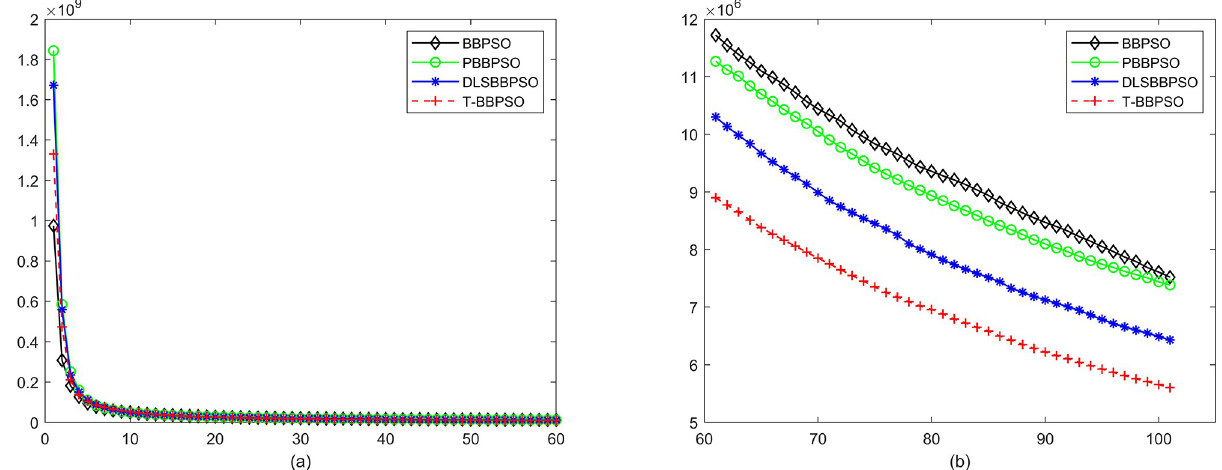
Fig 3. Comparison of convergence speed between BBPSO, PBBPSO, DLS-BBPSO and TBBPSO, f 1 , (a) iteration 0–6000, (b) iteration 6000–10000 the unit is 100 iteration.